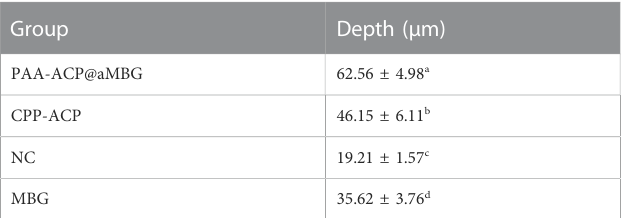
TABLE 4 The depth of the enamel remineralization zone in the four groups of samples ( n = 4). Group Depth ( μ m)